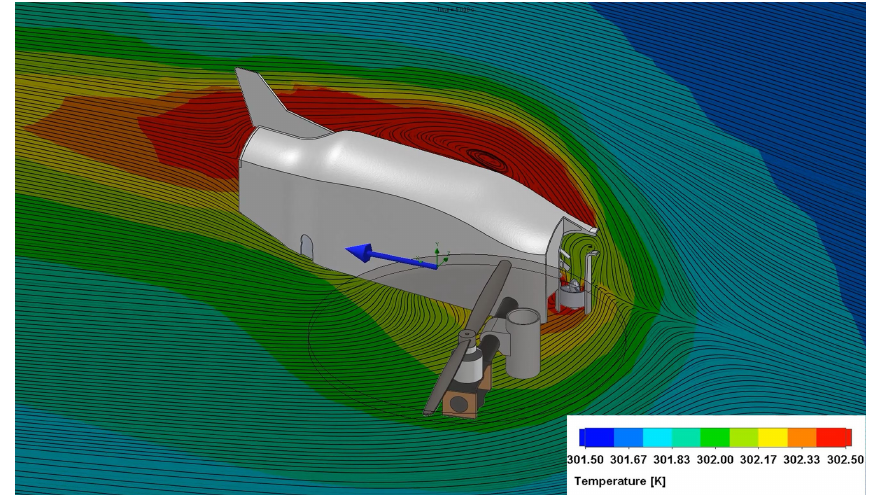
Figure 7. Longitudinal cross-section view of the airflow around the CopterSonde CAD model. It shows the CopterSonde facing into winds of 3 . 6ms − 1 blowing in the direction of the blue arrow. The color spectrum represents the air temperature (in Kelvin) and the streamlines show the flow trajectory. To save computational time and reduce complexity, the rear propellers were removed for the simulation since these are located downwind of the region of interest. Additionally, a section cut view of the L-shaped duct shows the airflow across the sensors and the fan.